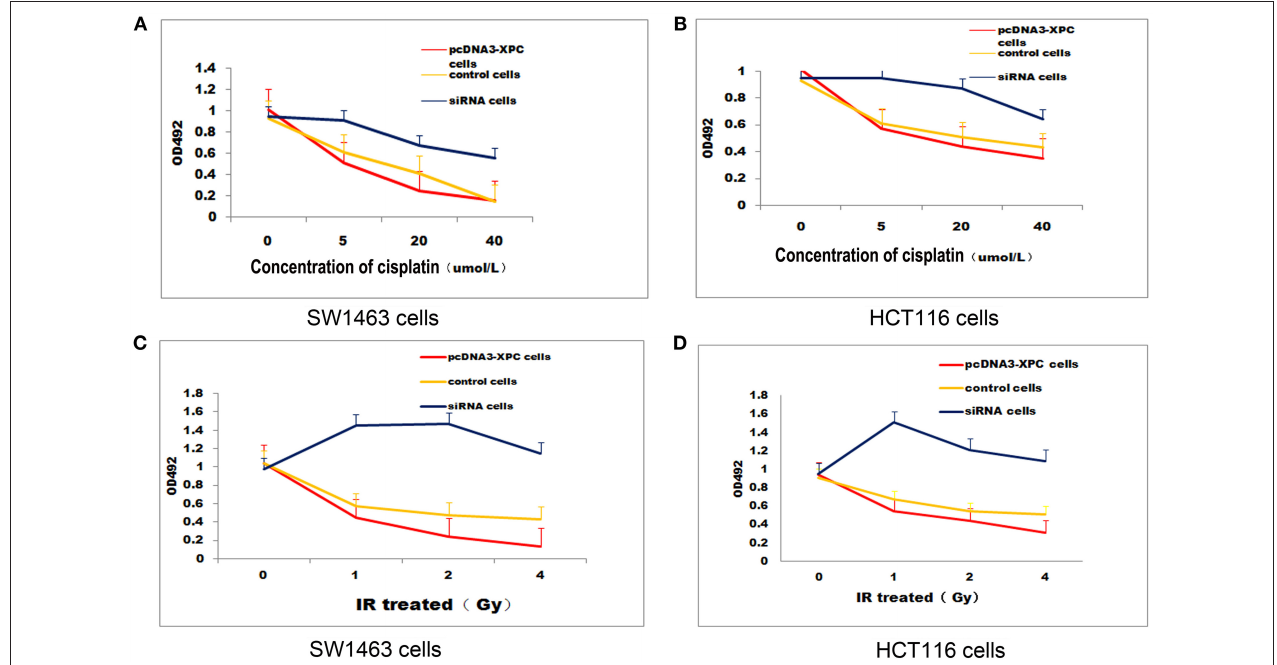
FIGURE 3 | XPCoverexpression suppressed cell growth in the presence ofIR or cisplatin. IR and cisplatin growth inhibition was evaluated in pcDNA3-XPC transfected cells and XPC silenced cells. pcDNA3-XPC transfected cell were more susceptible to IR radiation or cisplatin compared to control cells and siRNA cells. (A) Control SW1463 cells, pcDNA3-XPC transfected SW1463 cells and XPC silenced SW1463 cells were exposed to cisplatin at different concentrations, followed by MTT analysis after 4h. (B) Control HCT116 cells, pcDNA3-XPC transfected HCT116 cells and XPC silenced HCT116 cells were exposed to cisplatin at different concentrations, followed by MTT analysis after 4h. (C) Control SW1463 cells, pcDNA3-XPC transfected SW1463 cells and XPC silenced SW1463 cells were exposed to IR at different intensities, followed by MTT analysis. (D) Control HCT116 cells, pcDNA3-XPC transfected HCT116 cells and XPC silenced HCT116 cells were exposed to IR at different intensities, followed by MTT